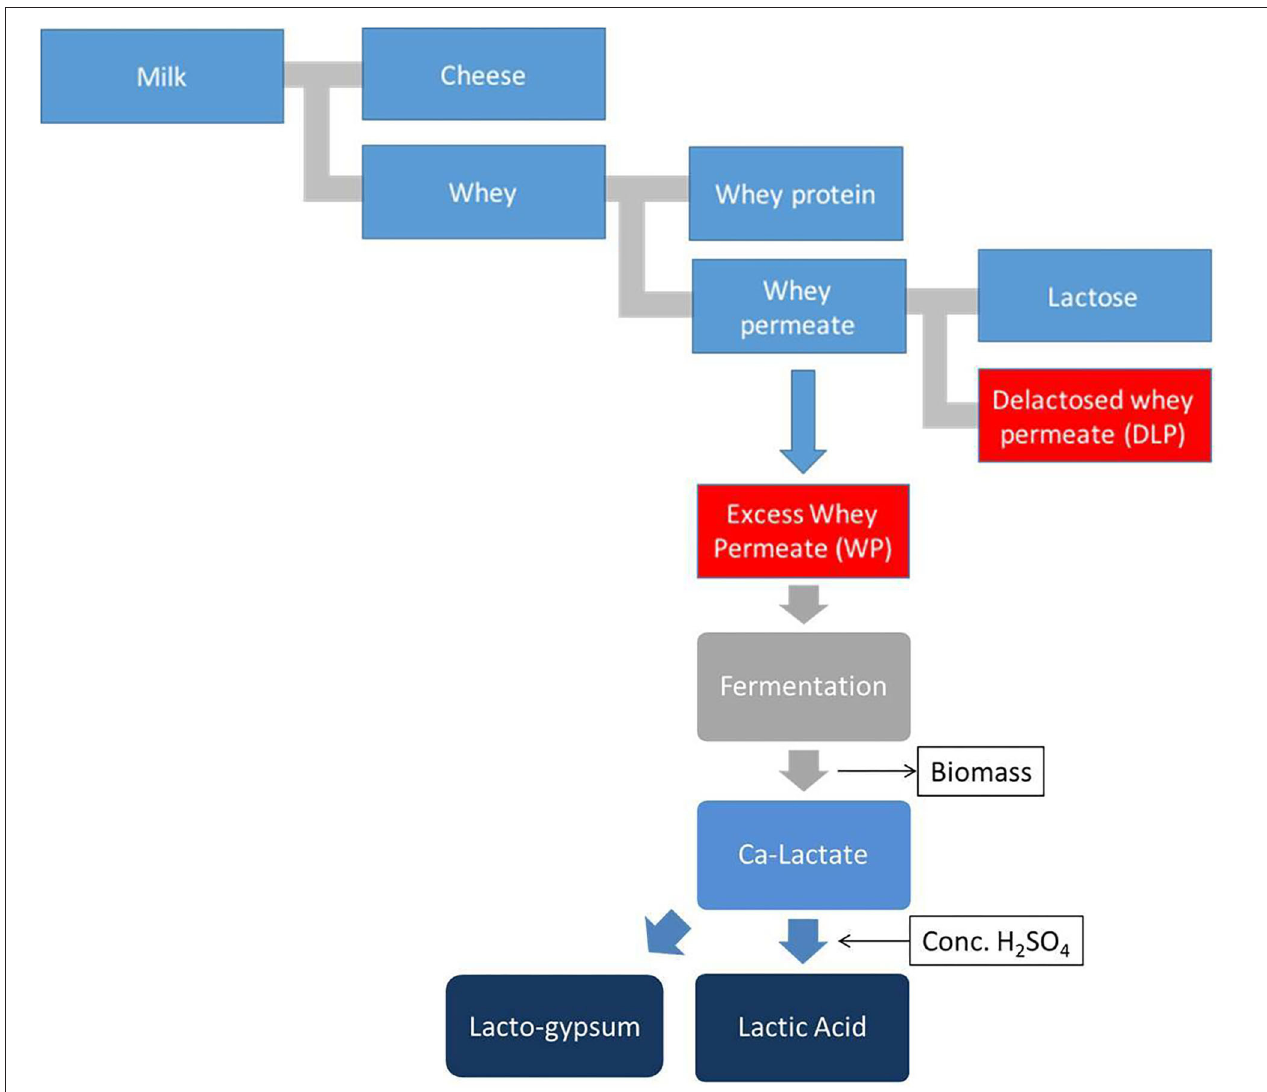
FIGURE 1 | Graphical representation of the whey permeate treatment process and lacto-gypsum production.